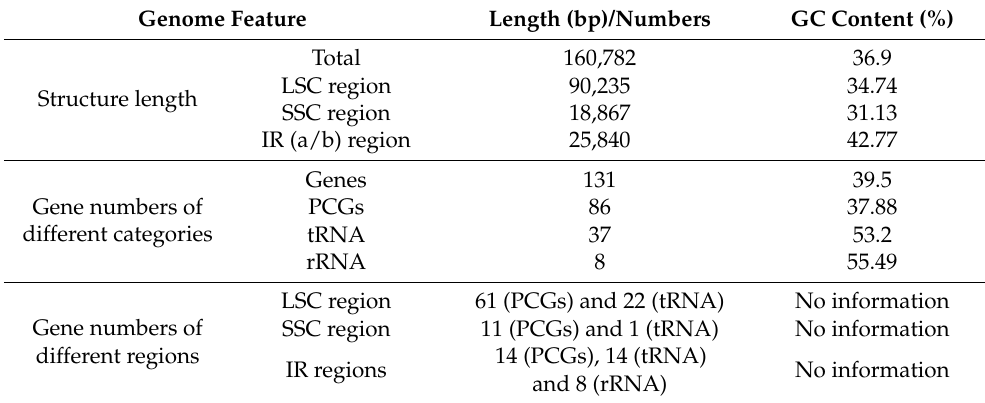
Table 1. Chloroplast genome structure and feature of Q. litseoides . Abbreviations: LSC (Large Single Copy), SSC (Small Single Copy), IR (Inverted Repeat), PCGs (protein-coding genes), tRNA (Transfer RNA genes), and rRNA (Ribosomal RNA